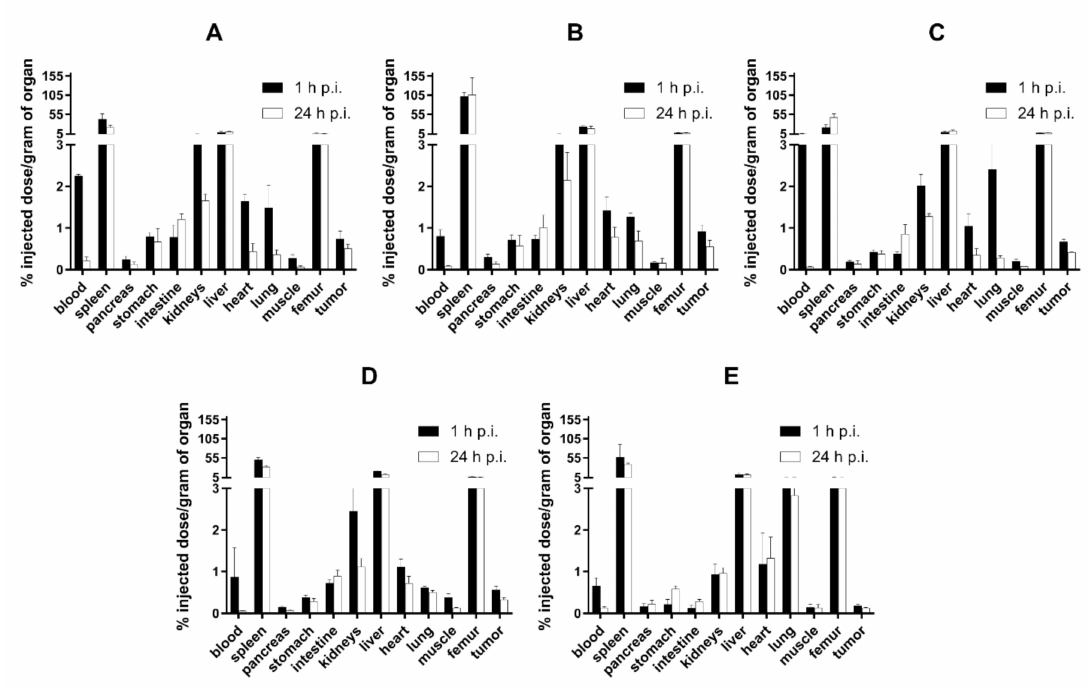
Figure 5. Biodistribution of retroorbitally (r.o.) injected 99m Tc-PEG2000-HAP ( A ), 99m Tc-PEG5000-HAP ( B ), 99m Tc-POX5000-HAP ( C ), 99m Tc-POX10000-HAP ( D ) and 99m Tc-PHPMA5000-HAP ( E ) in tumor (HT-29) SCID mice 1 and 24 h p.i. ( n = 3 animals per time point).